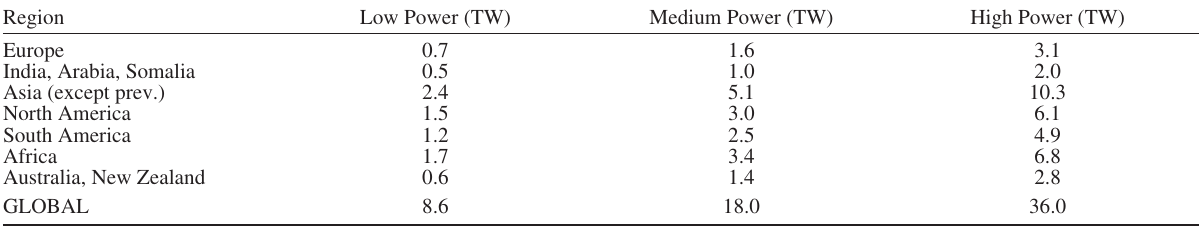
Table 3. – Solar power extracted from CSP stations in different regions if 5 TWe were to be produced globally.